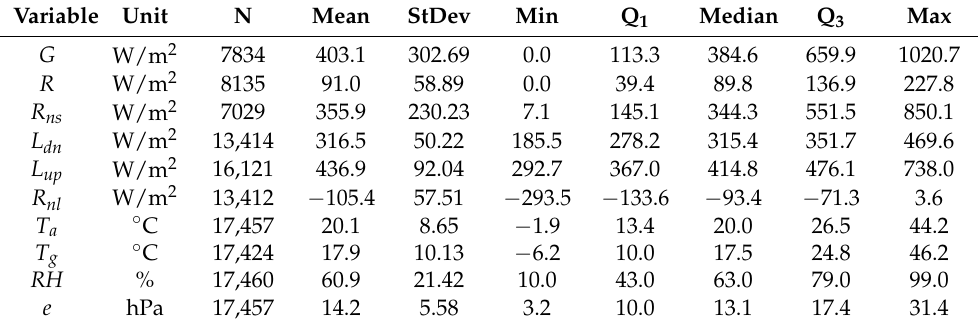
Table 3. Annual basic statistics of the hourly global ( G ), reflected (R), net shortwave ( R ns ), downward ( L dn ), upward ( L up ) and net longwave ( R nl ) irradiances in W m − 2 , air temperature at the screen level ( T a ), air temperature near the ground surface ( T g ), relative humidity ( RH ), and actual vapor pressure ( e ) for the period of two years